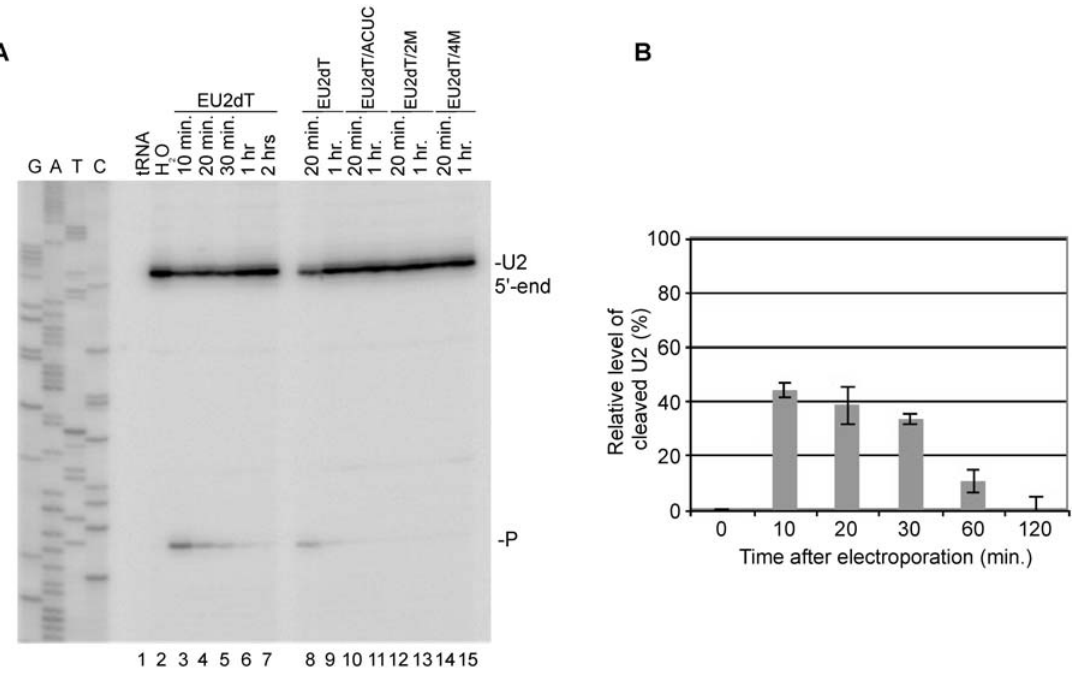
Figure 6. Small RNA guides induce Rnt1p cleavage invivo. (A) Mapping the RNA-directed cleavage of U2 from living yeast cells. Yeast cells were electroporated with 2 nmols of EU2dT or mutant RNA guides and total RNA was extracted between 10 minutes and 2 hours after electroporation. The primer PE-U2-Br was annealed with the RNA samples and extended on U2 snRNA. The corresponding DNA sequence is shown on the left. (B) Relative levels of cleaved U2 snRNA after electroporation were established using RNA extracted in A and loaded on 1.2% agarose-formaldehyde gel, transferred to a nylon membrane and hybridized with probes specific for nucleotides 7 to 29 into mature U2 or against the 25S rRNA to serve as internal control and visualized by Phosphor Imager. The intensity of each band was quantified using Image Quant 5.0. The levels of U2 snRNA were normalized against the 25S rRNA and the electroporation efficiency (53 6 8%), and were plotted as a function of time after electroporation with EU2dT.